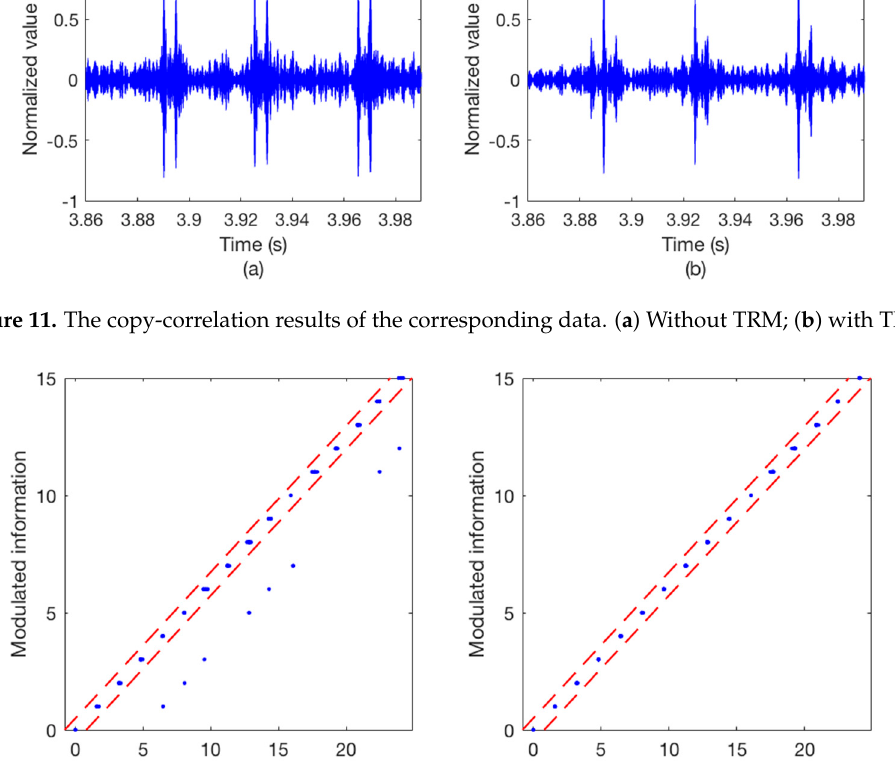
Figure 11. The copy-correlation results of the corresponding data. ( a ) Without TRM; ( b ) with TRM.